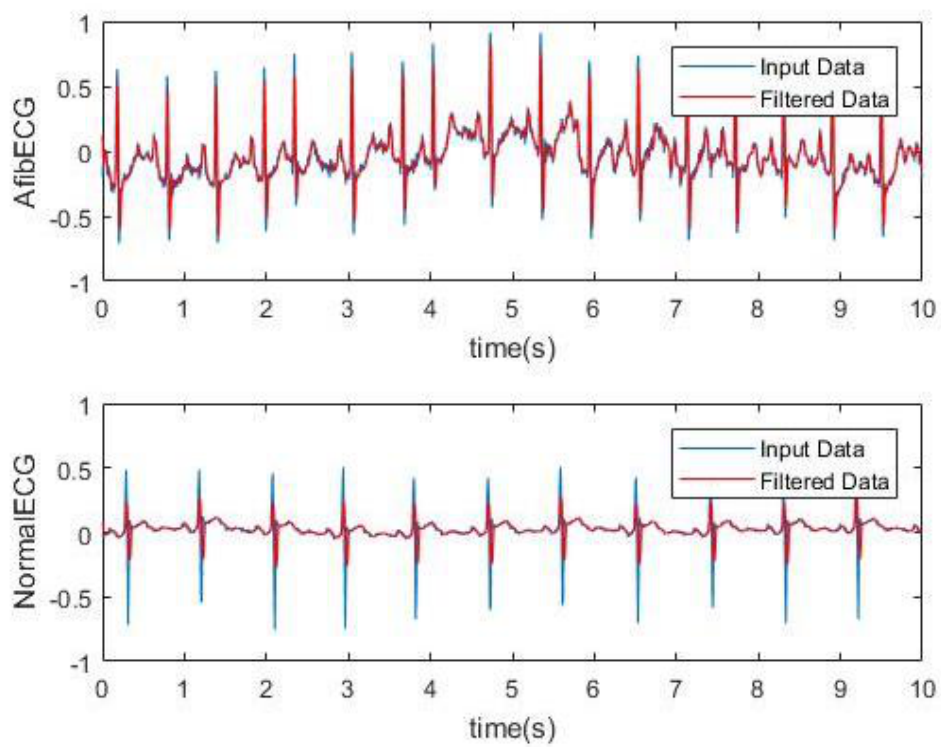
Figure 10. Comparison of characteristics of AF and healthy ECG signals (10 s).